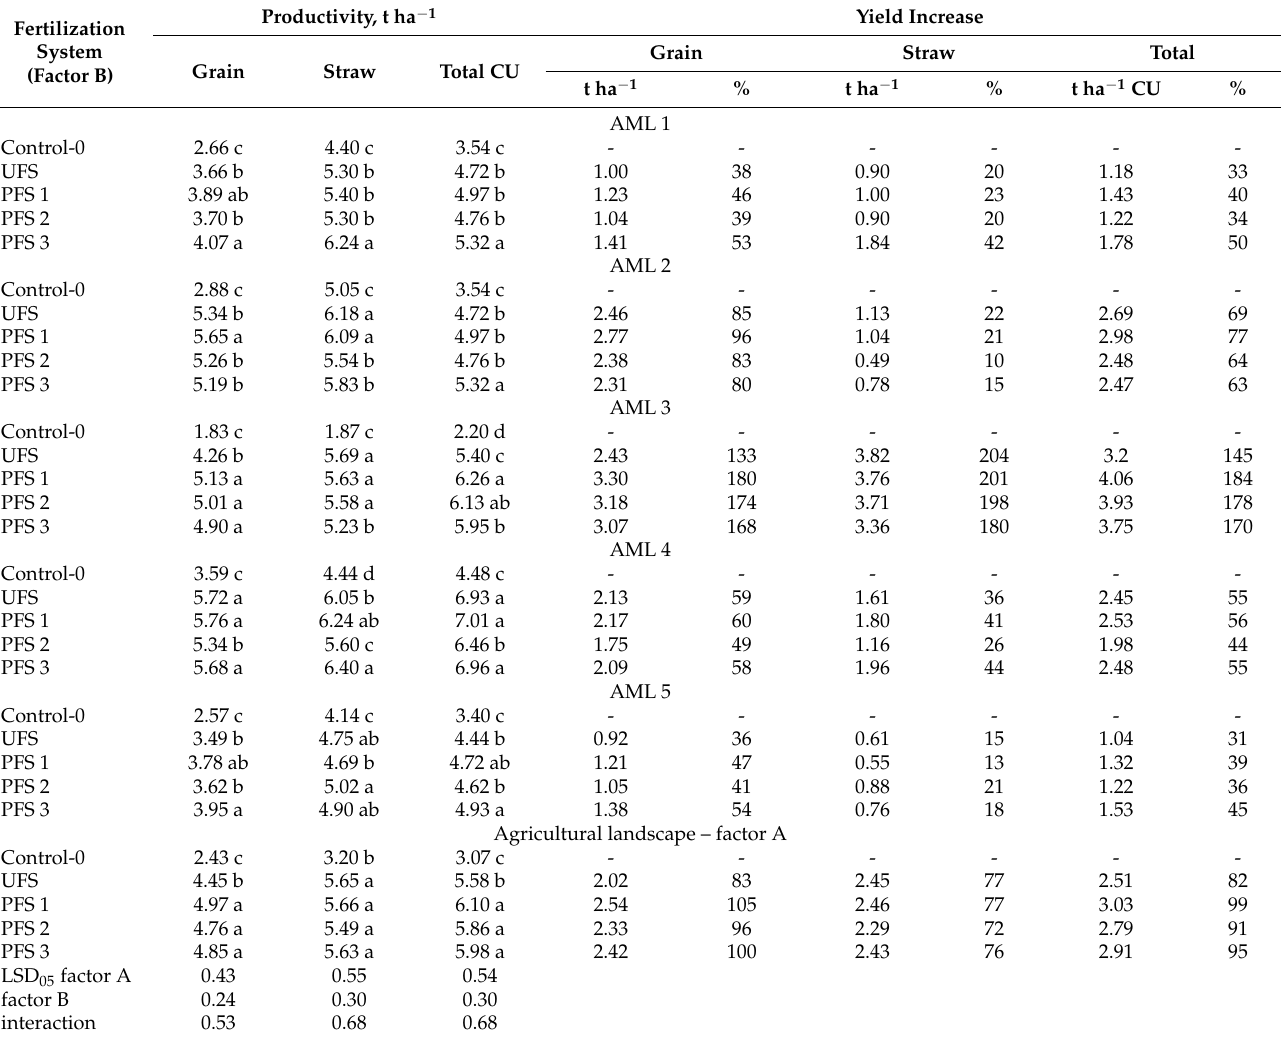
Table 4. Effect of AML conditions and fertilizer systems on winter wheat